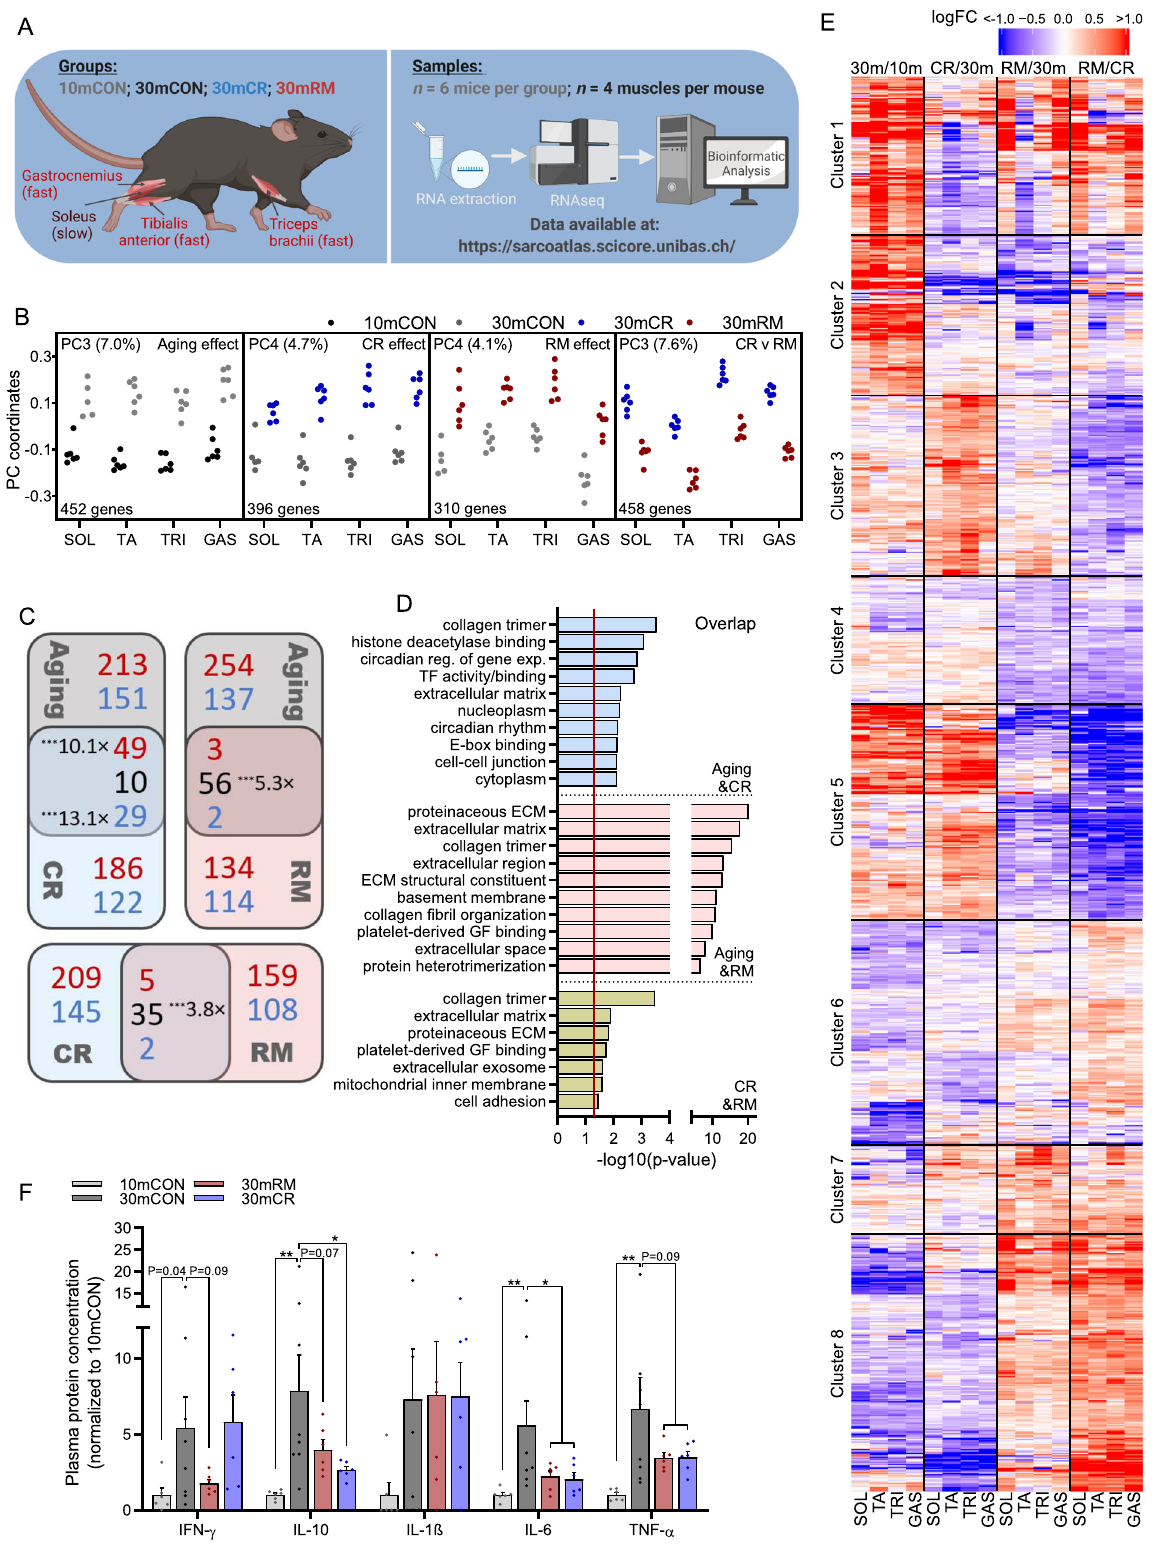
speci fi c force (Fig. 4K) and peak tetanic force normalized to body mass (Fig. 4L) in isolated SOL and EDL muscle in both WT and TSCmKO mice. Despite reducing absolute muscle mass in both WT and TSCmKO mice, CR reduced EDL (Supplementary Fig. 4E) and SOL (Supplementary Fig. 4F) absolute peak tetanic force only in WT mice, but not in TSCmKO